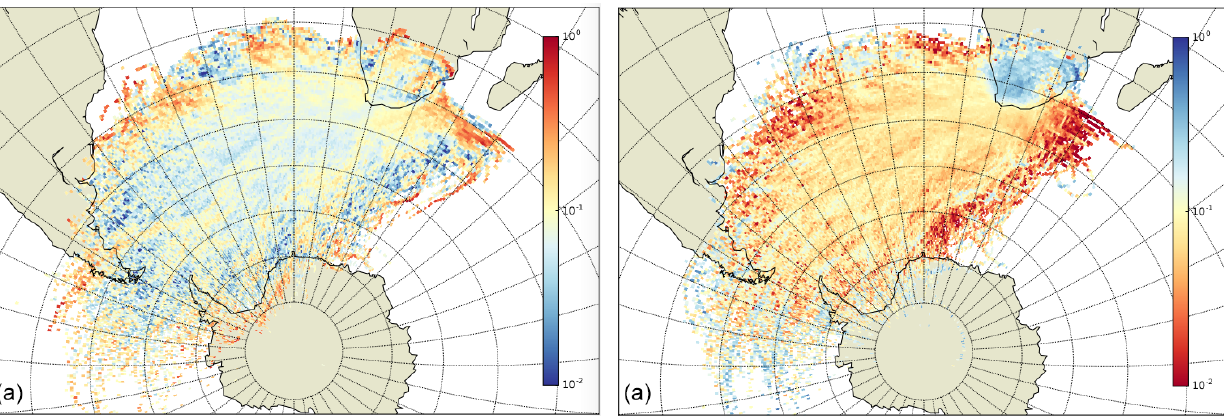
Figure 5. Prevalence of (a) highest (90th percentile) and (b) lowest (10th percentile) GEM concentrations using all hourly trajectories over 10